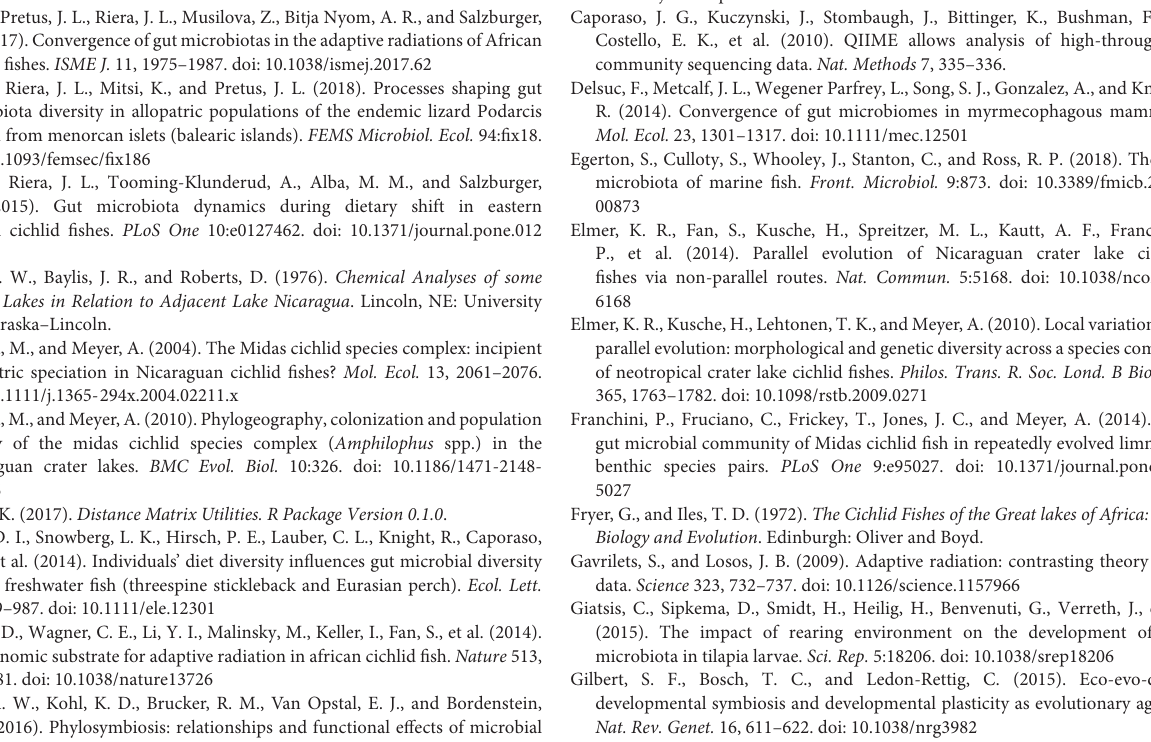
FIGURE S2 | Principal Coordinates Analysis based on Unweighted Unifrac distances depicting comparisons across the three species/ecological niches in L. Xiloá and L. Apoyo. The centroids by species are shown. No significant differences among species were found (Adonis, p > 0.05). FIGURE S3 | Venn diagrams showing shared and unique OTUs (A) between large lakes and L. Masaya versus the other crater lakes, (B) among crater lakes